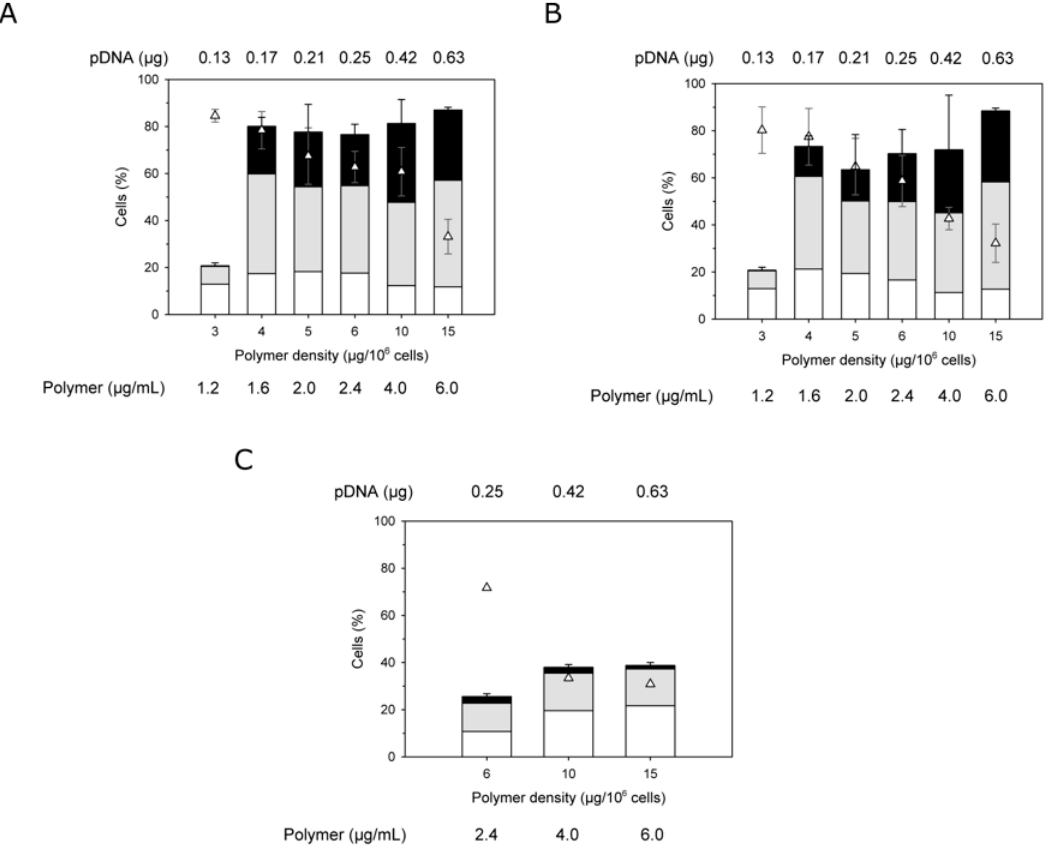
Figure 6. Transfection in Eppendorf tubes as a function of the polymer densities. ( A ) 90 min incubation, ( B ) 30 min incubation, ( C ) 15 min incubation. (0.2 × 10 6 cells, N/P 10, transfection volume 0.5 mL. Bars represent the percentage of transfected cells, with white: low producers, grey: middle producers, black: high producers; (cid:52) : viabilities. Shown are mean values ± SD, n ≥ 2, SD given for total transfection efficiencies and for viabilities.)